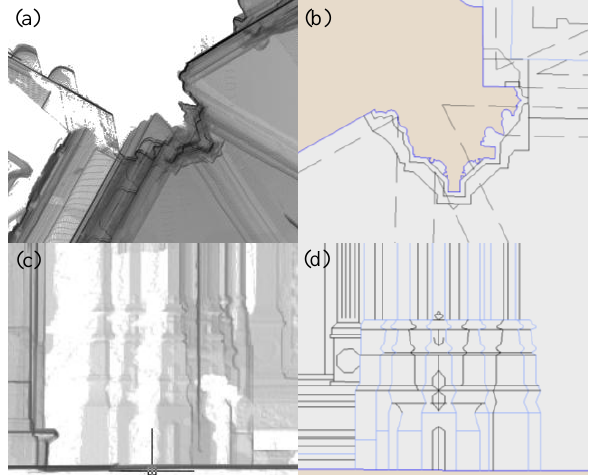
Figure 3. The laser data of a pillar in the Marquis Chapel and its drawing (PointCab horizontal section(a), 2D horizontal drawing (b), PointCab vertical section(c), 2D vertical drawing (d)) .